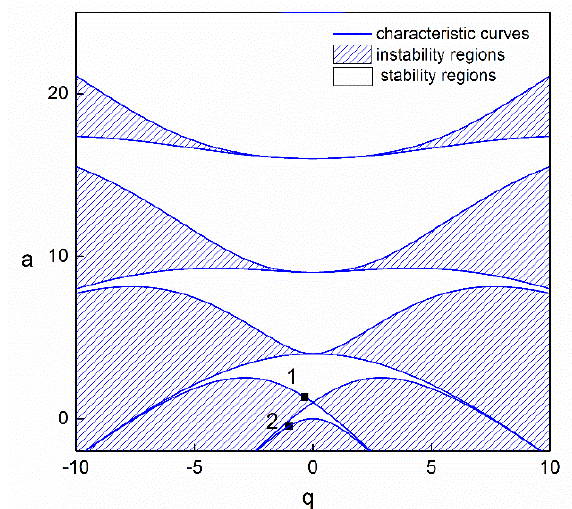
Figure 2. The stability chart for the solutions of the Mathieu’s equation with the parameters (a, q) . The solid lines correspond to characteristic curves, the hatched areas depict the instability regions, the empty areas – stability regions. The solutions marked by the points ‘1’ and ‘2’ are analyzed in the